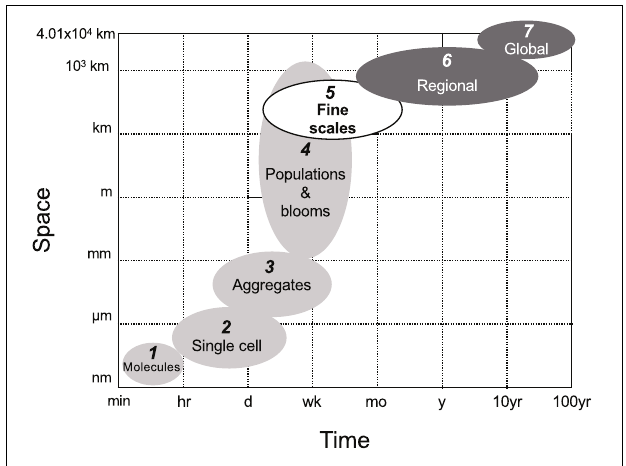
FIGURE 1 | The spatiotemporal scales of diazotrophy studies in the ocean ranging from minutes to 100 years in time and from nm to 4.01 × 10 4 km (the circumference of the Earth) in space. Light and dark gray ellipsoids depict the spatiotemporal scales of diazotrophy studied to date, i.e., lower and larger scales in light and dark gray, respectively. The white ellipsoid depicts the current gap in knowledge: the fine scales. This gap can only be filled by developing novel methods capable of measuring diazotroph community composition, abundance and activity at high spatiotemporal resolution. (1) We refer as “molecules” to molecular processes covered in transcriptomic studies. Gene transcription typically takes place in a time range of minutes.